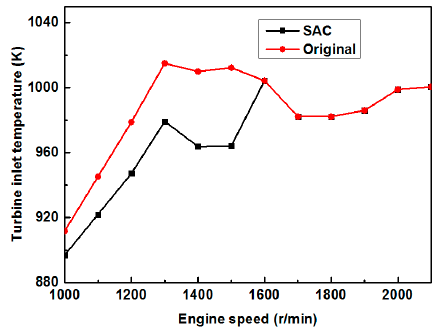
Figure 8. Full load optimization results. Turbine inlet temperature T ex .